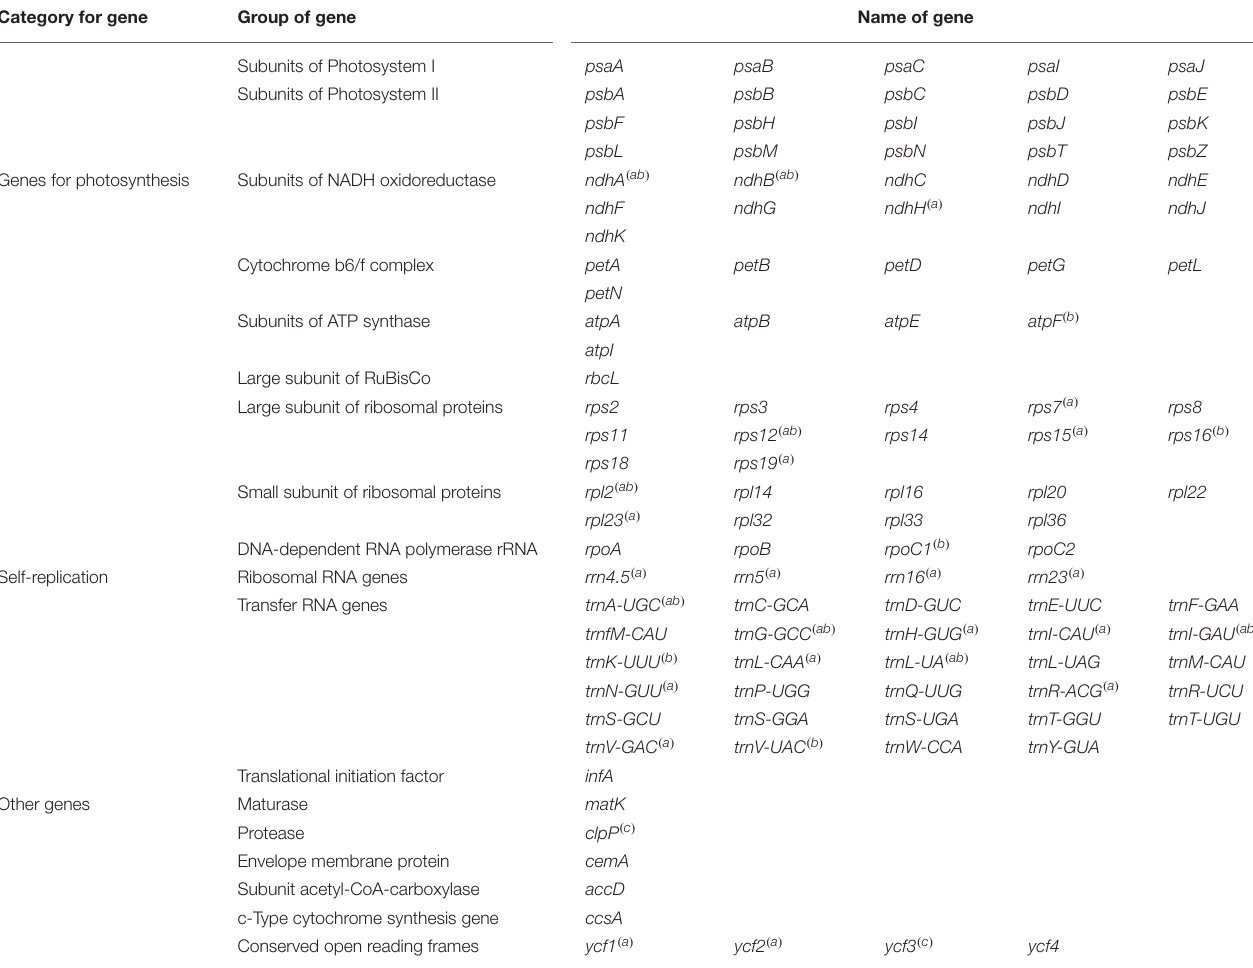
TABLE 2 | List of predicted genes in the Musa chloroplast genome. Category for gene Group of